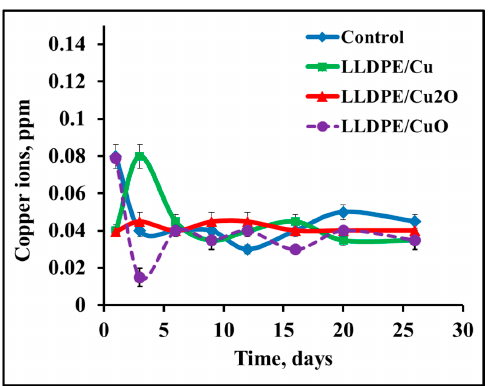
Figure 4. Leaching of copper ions into saline from composites of LLDPE and NPs of copper and copper oxides. Control—saline solution.